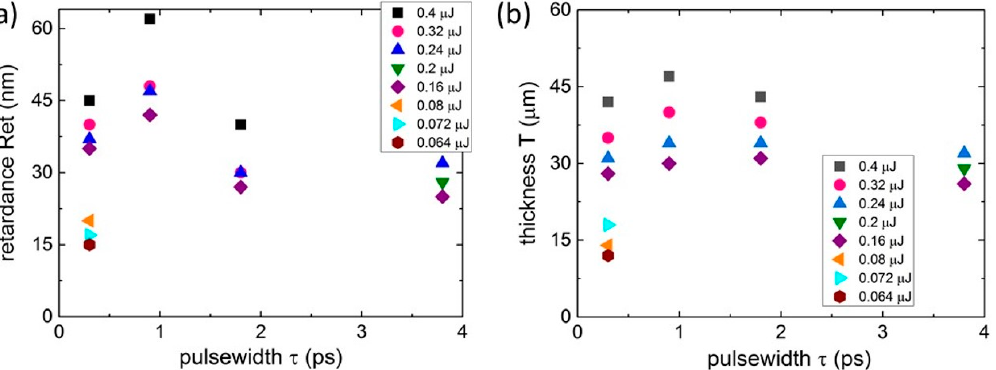
Figure 2. Retardance Ret ( a ) and thickness T ( b ) magnitudes versus pulsewidth τ at different 515 nm laser pulse energies (symbols of different shapes and colors). Maximal relative error bars ≤ 10%.